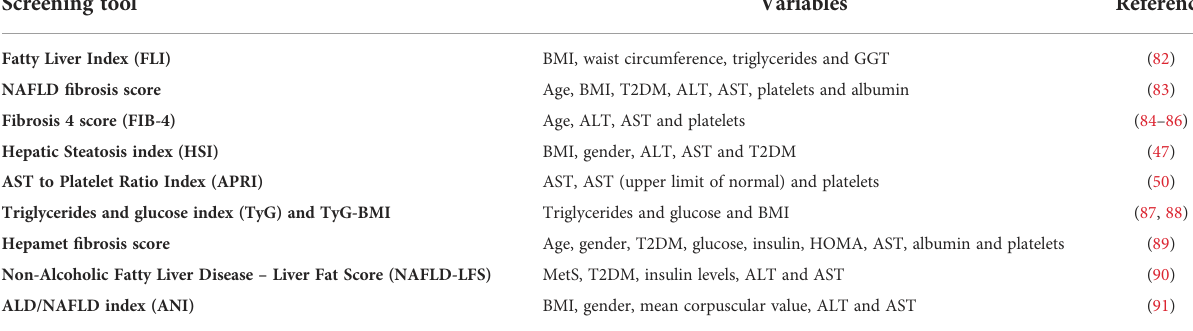
TABLE 2 Indexes to determine hepatic steatosis or fi brosis and variables needed. Screening